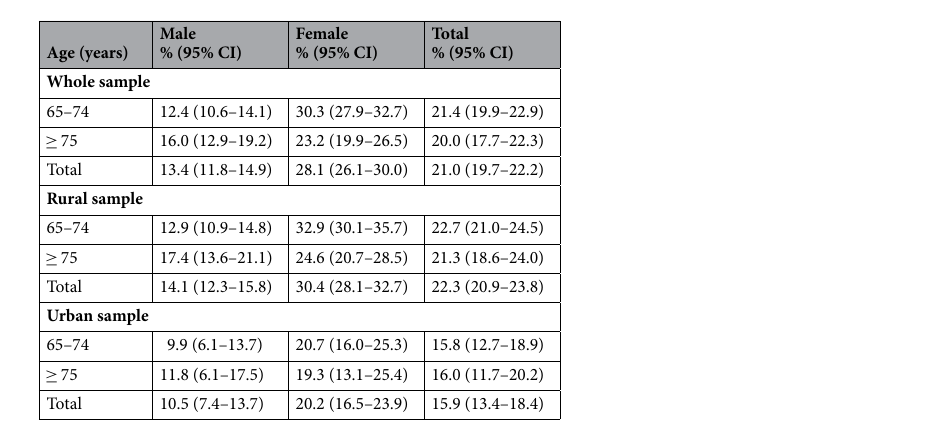
Table 3. Prevalence of poor sleep quality by age, gender and region. CI confidential interval.